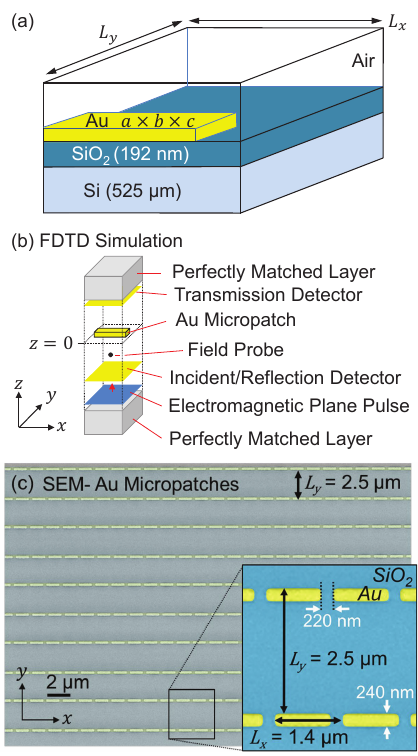
Figure 1. ( a ) Schematic illustration of a unit cell of the gold micropatch array, on the surface of a SiO 2 /Si substrate. ( b ) Configuration of the FDTD study. ( c ) SEM images of an experimentally fabricated Au/Ti micropatch array (colourised for clarity) ( a = 1.18 µ m, b = 0.24 µ m, c = 50 nm, L x = 1.4 µ m and L y = 2.5 µ m), total array area = 2 × 2 mm 2